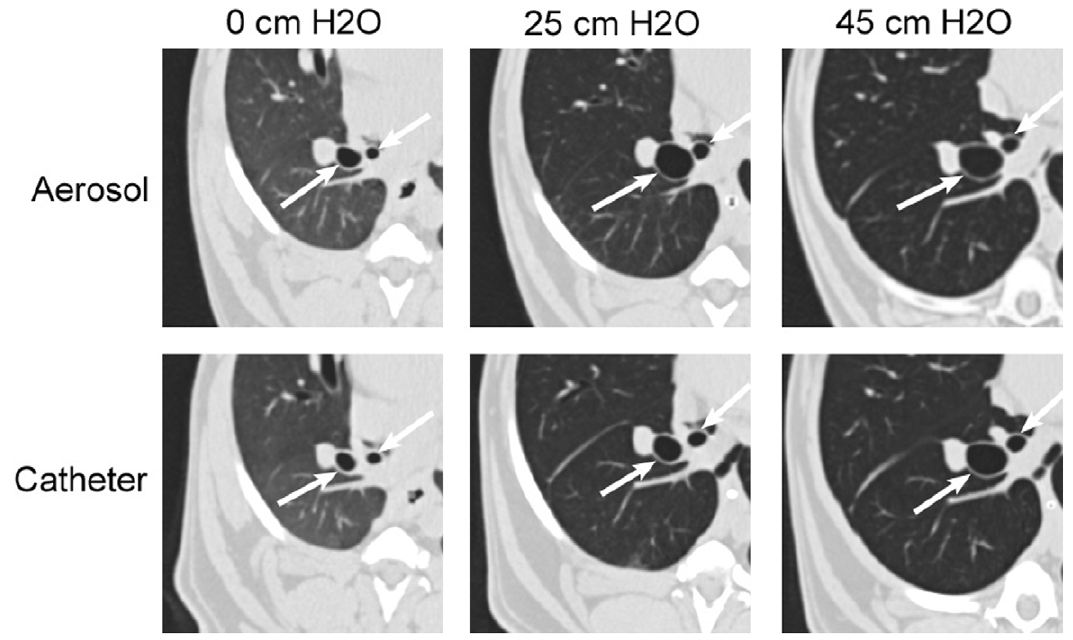
Figure 2. Representative HRCT images at three pressures with either the local catheter or whole lung aerosol challenge. Two individual airways identified by the arrows are seen in all the images. The airway sizes at 0 and 45 cm H 2 O appear similar with either challenge, but at 25 cm H 2 O, the airways with the catheter stimulation are clearly smaller than with the aerosol challenge.